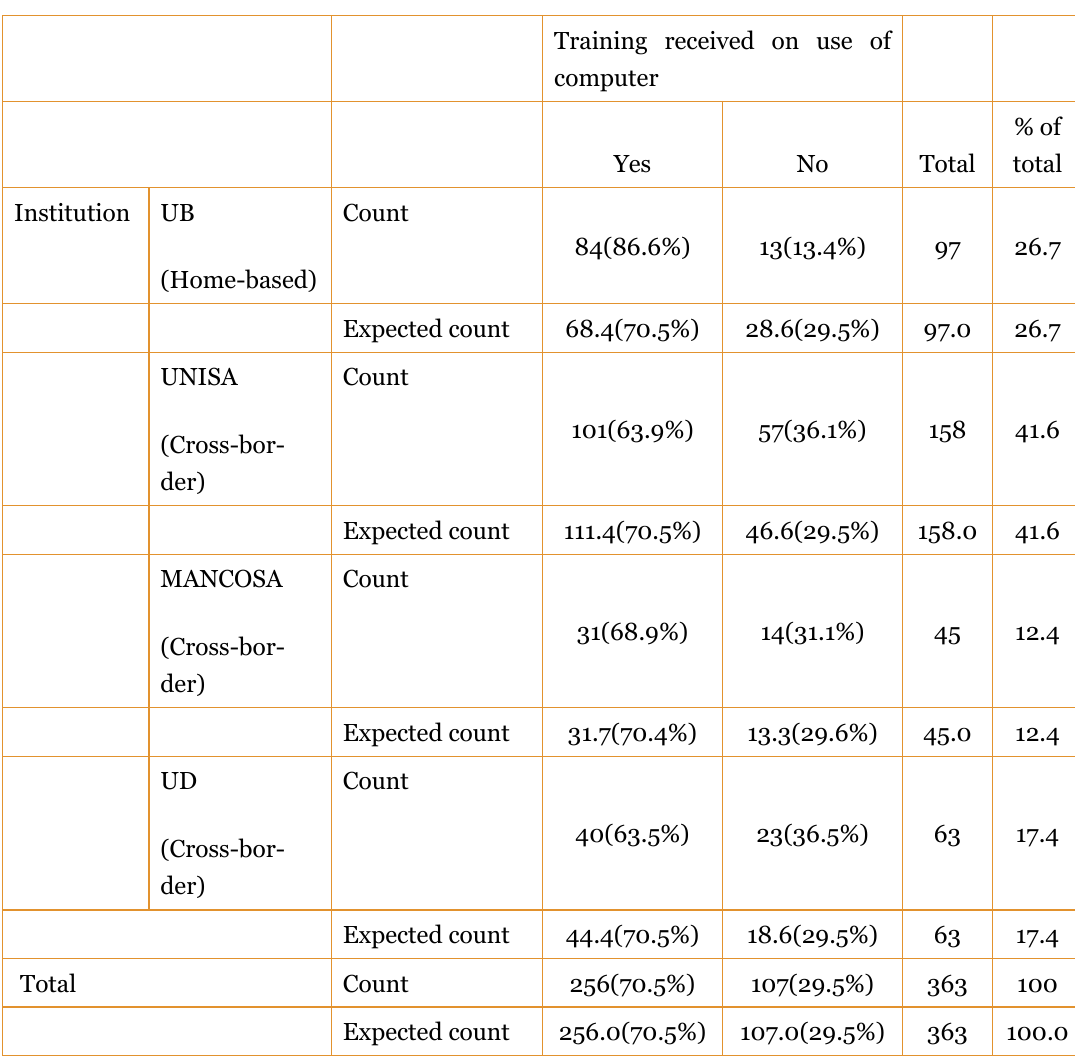
Institution – Did/Do you Receive any Training on the Use of a